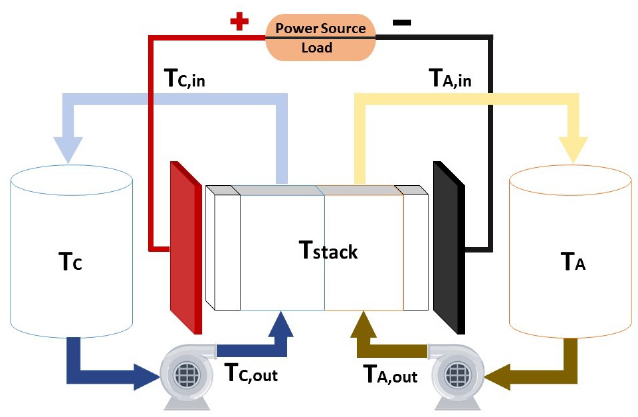
Figure 3. System temperature measurements.